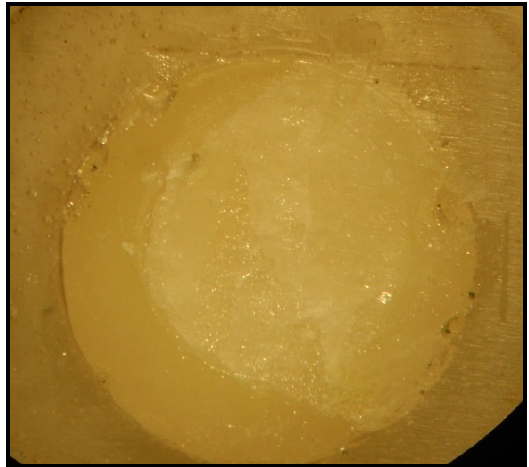
Figure 5. The specimen shows a cohesive type of bond failure.